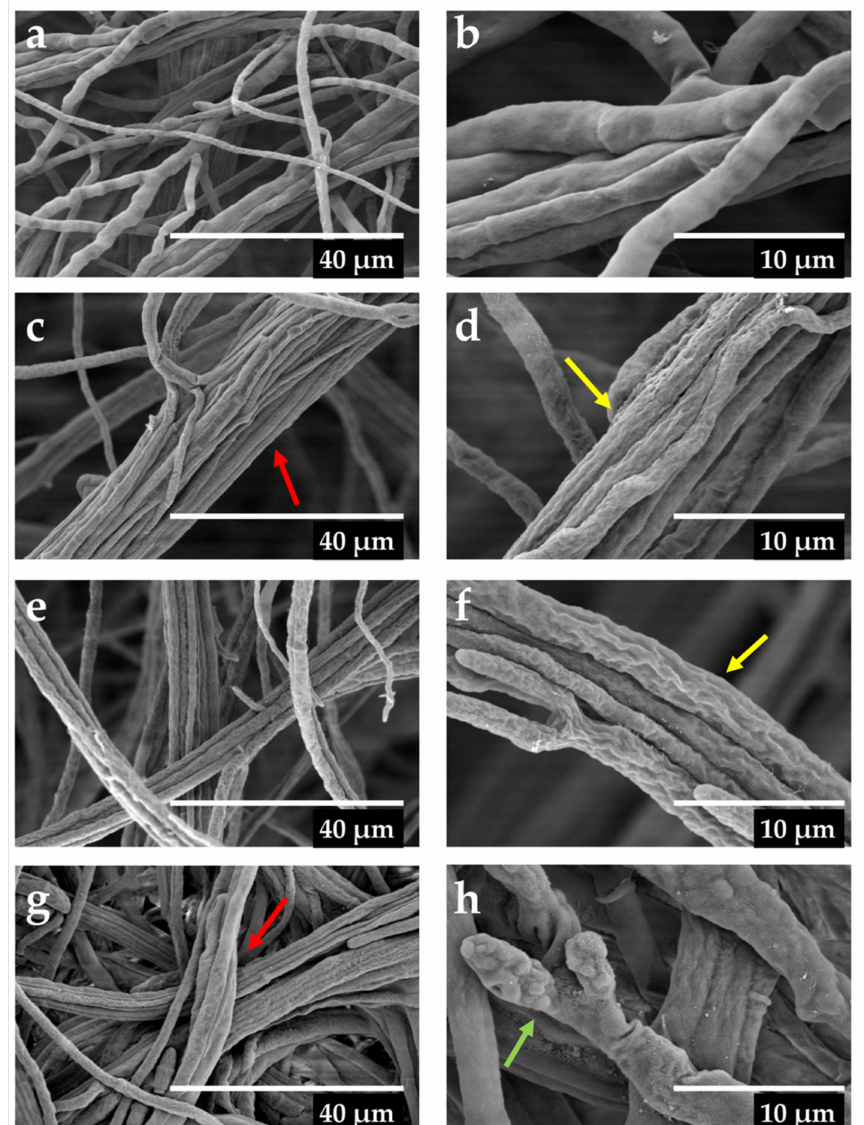
Figure 3. Morphological alterations in hyphae of F. kuroshium observed by scanning electron mi- croscopy (SEM) caused by the secondary fractions of C. nocturnum after six days of exposure. ( a ) con- trol (extract vehicle: H 2 O-MeOH in a 15:85 ratio) at 5000 × . ( b ) control (extract vehicle: H 2 O-MeOH in a 15:85 ratio) at 15,000 × . ( c ) ECn-F4-16 (0.5 mg mL − 1 ) at 5000 × . ( d ) ECn-F4-16 (0.5 mg mL − 1 ) at 15,000 × . ( e ) ECn-F4-18 (0.2 mg mL − 1 ) at 5000 × . ( f ) ECn-F4-18 (0.2 mg mL − 1 ) at 15,000 × . ( g ) ECn-F4- 20 (0.5 mg mL − 1 ) at 5000 × . ( h ) ECn-F4-20 (0.5 mg mL − 1 ) at 15,000 × . Yellow, red and green arrows show wrinkles, agglomerations and conglobations,